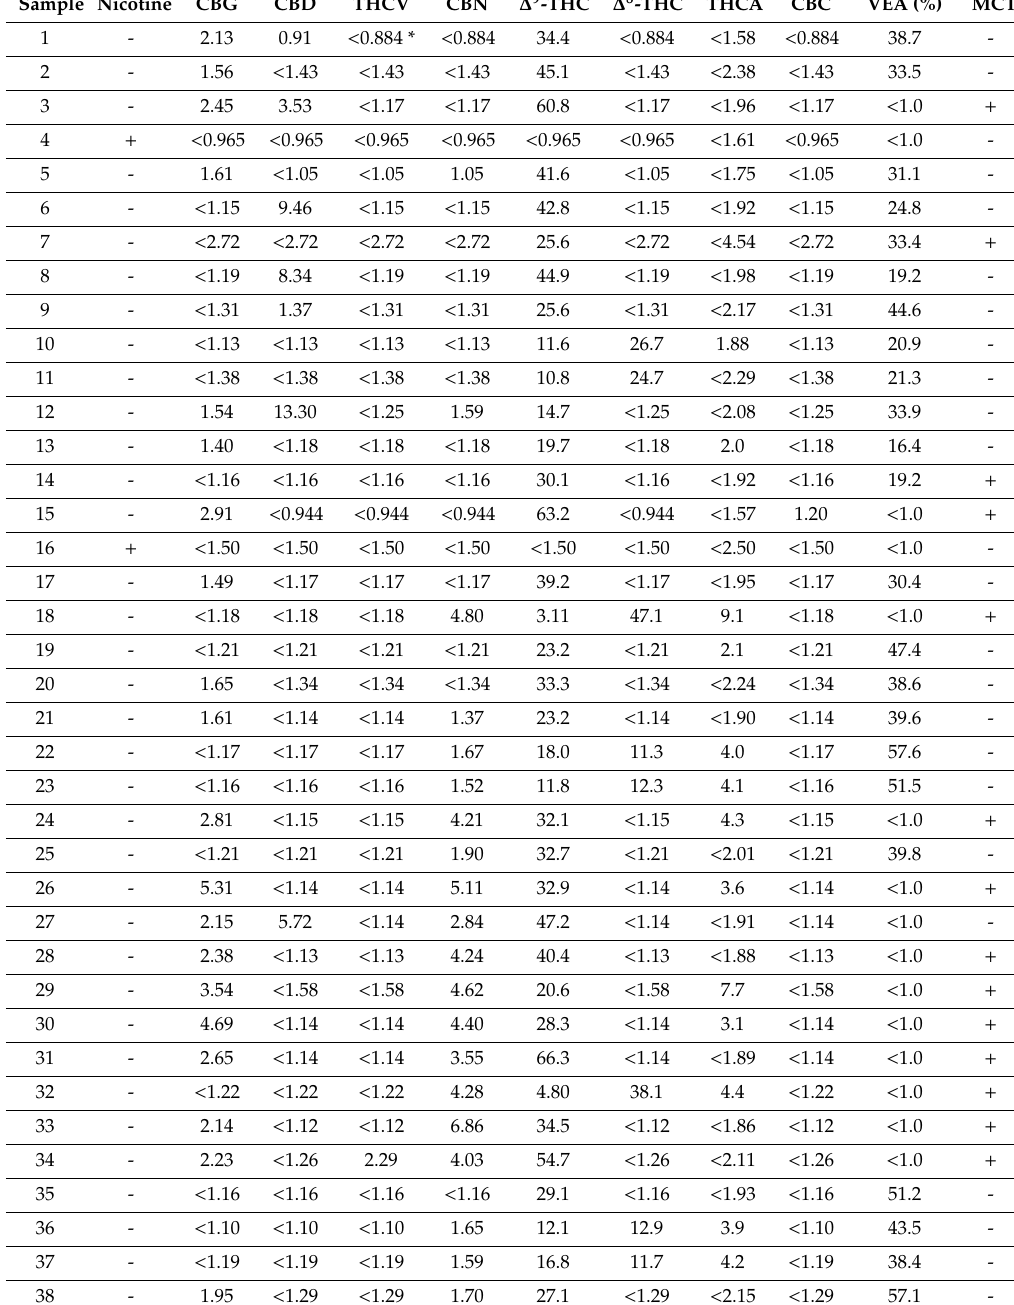
Table 1. Nicotine, cannabinoids, and additives in vaporizer fluids